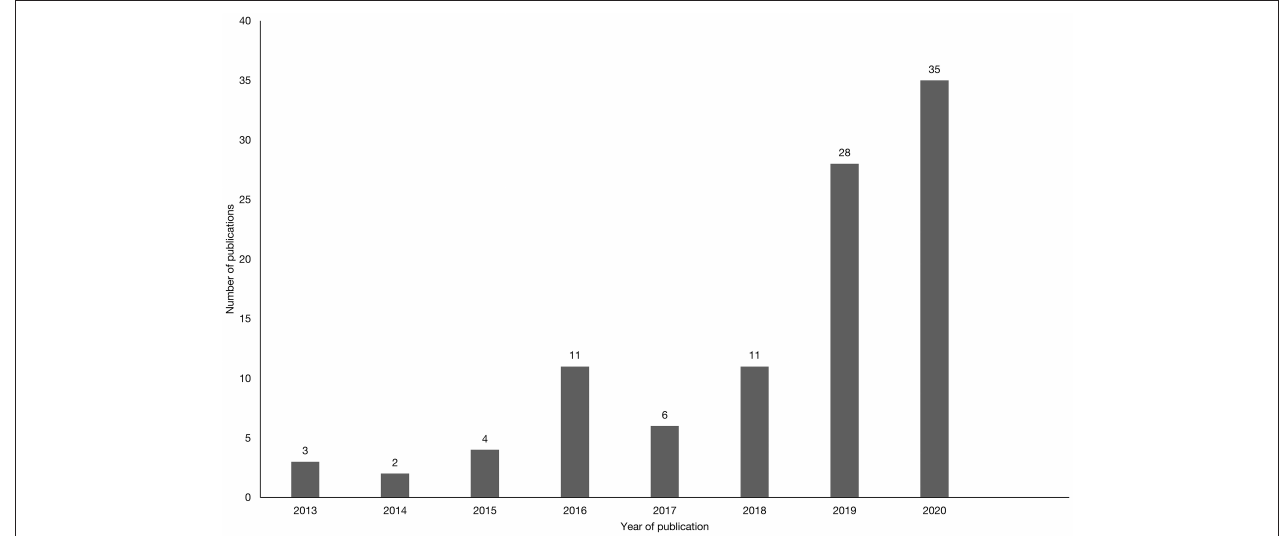
FIGURE 3 | Development of publications on the acceptance of insects as food in Western